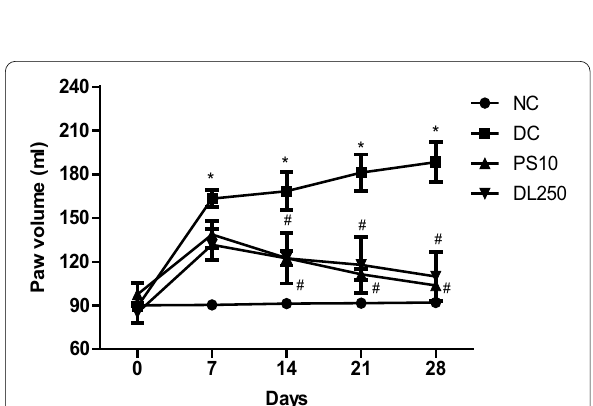
Fig. 1 Effect of C. procera on body weight of CFA-induced arthritic rats. Data represented as mean SEM; * p < 0.05 compared to NC ± group (two-way ANOVA followed by Bonferroni’s post hoc test). NC normal control group, DC CFA-induced arthritic group, PS10 prednisolone-treated group, DL250 dry latex of C. procera -treated group